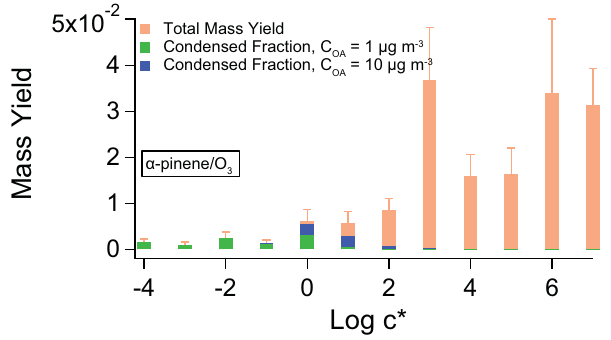
Figure 6. Estimated mass yield of compounds measured by the acetate-CIMS for α -pinene ozonolysis (Expt 1), binned by log c ∗ . Colored in green is the fraction that would condense with C OA = 1µgm − 3 and colored in blue is the additional mass that would con- dense with C OA = 10µgm − 3 . Error bars represent 1 σ uncertainty from spectral variation, precursor concentration, and sensitivity